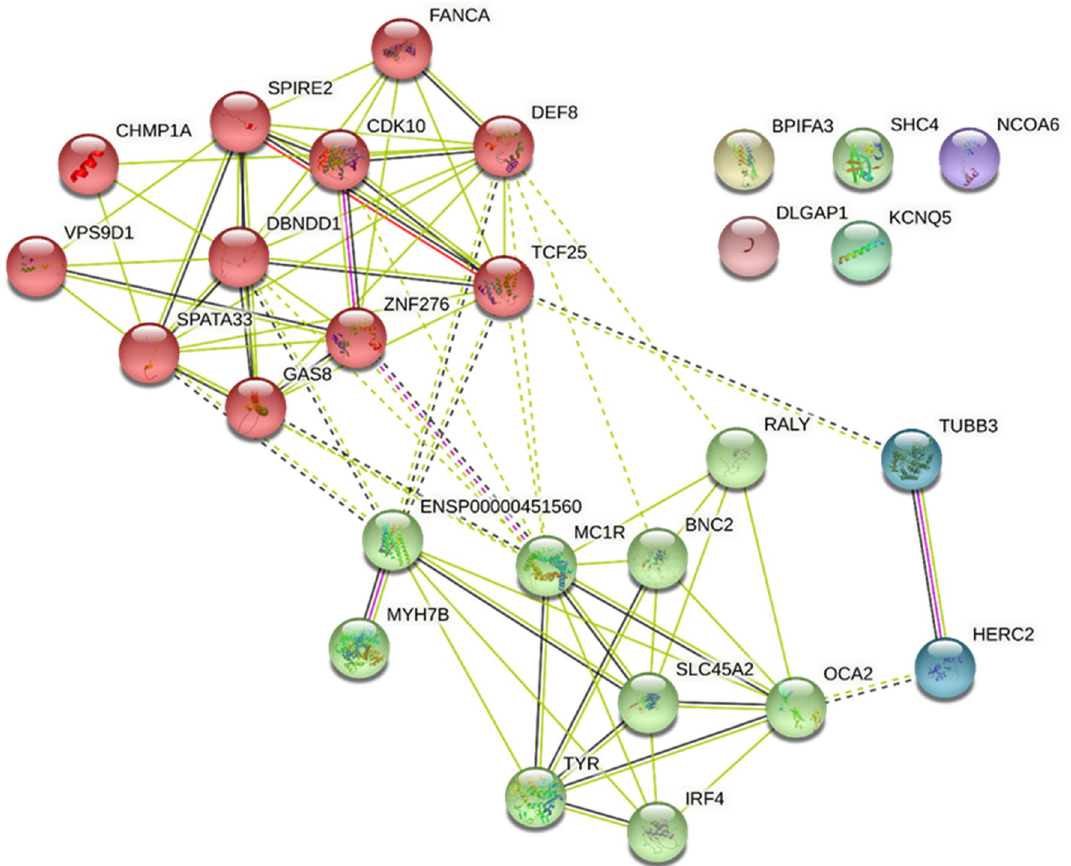
Figure 4. Functional enrichment analysis of skin ageing genes. Each gene shown in this figure is associated with two or more morphologically distinct phenotypes from different phenotypic categories (e.g., Phenotype Category A, B, C, and D). Nodes coloured red represent genes on the chromosomal band 16q24.3 and nodes coloured green represent skin colour genes. Edges (i.e., lines) linking the node indicate evidence of enrichment between the two connected